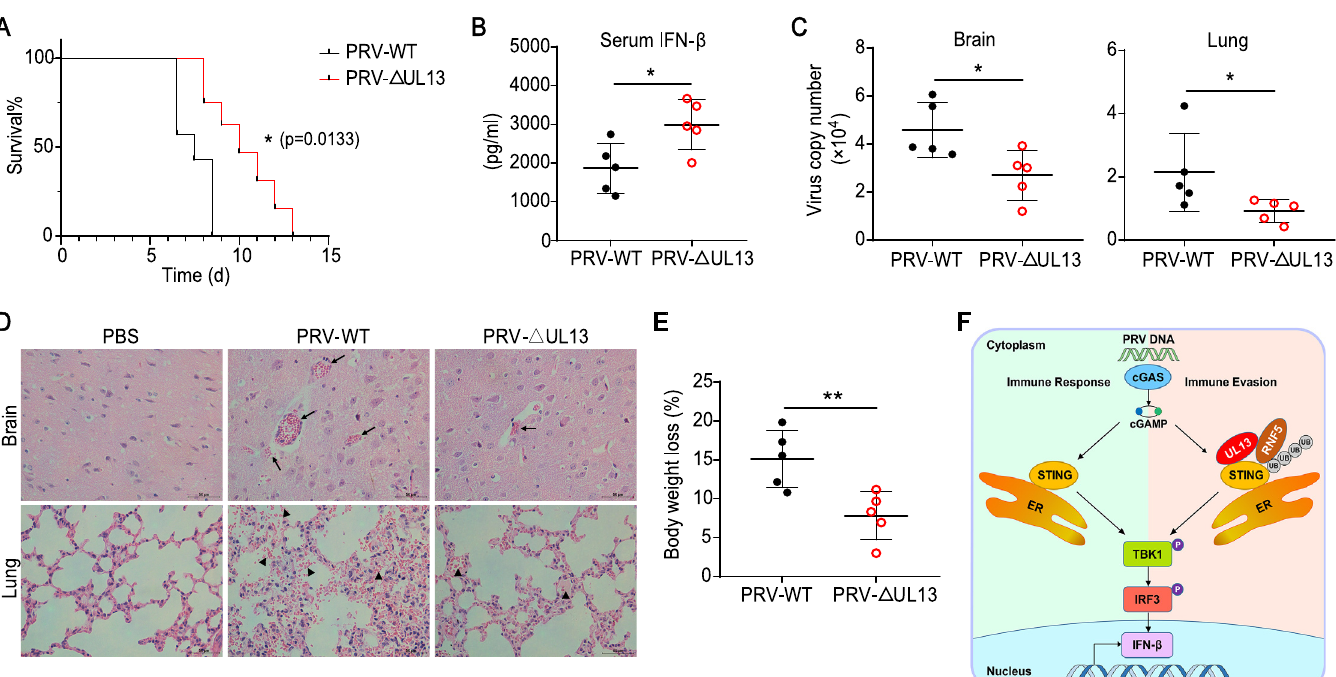
Fig 7. UL13 deficiency enhances host defense against PRV infection in vivo . (A) Survival rate of C57BL/6 mice (n = 7 in each group) infected with a lethal dose (0.5 × 10 6 PFU, the same below) of PRV-WT or PRV- Δ UL13. (B) ELISA of IFN- β in serum from mice infected with a lethal dose of PRV-WT or PRV- Δ UL13 (n = 5 in each group). Serum was collected 24 h post-infection. (C) qPCR analysis of viral propagation in tissue of mouse brain and lungs at day 6 after infection with a lethal dose of PRV-WT or PRV- Δ UL13 (n = 5 in each group). (D) Hematoxylin and eosin (H&E) staining of sections of brain and lung of mice as in (C); arrows indicate cerebral vascular congestion and hemorrhage in brain; triangles indicate diffuse alveolar hemorrhage or alveolar exudates. Scale bars, 50 μ m. Original magnification, × 40. (E) Body weight loss of mice infected with PRV-WT or PRV- Δ UL13 as in A at day 6. (F) A working model of how UL13 regulates the STING-mediated immune response. Data are representative of two independent experiments (A, D) or one independent experiment (B, C, E; mean ± SD). � p < 0.05, �� p < 0.01 (Student’s unpaired t test or log-rank test in